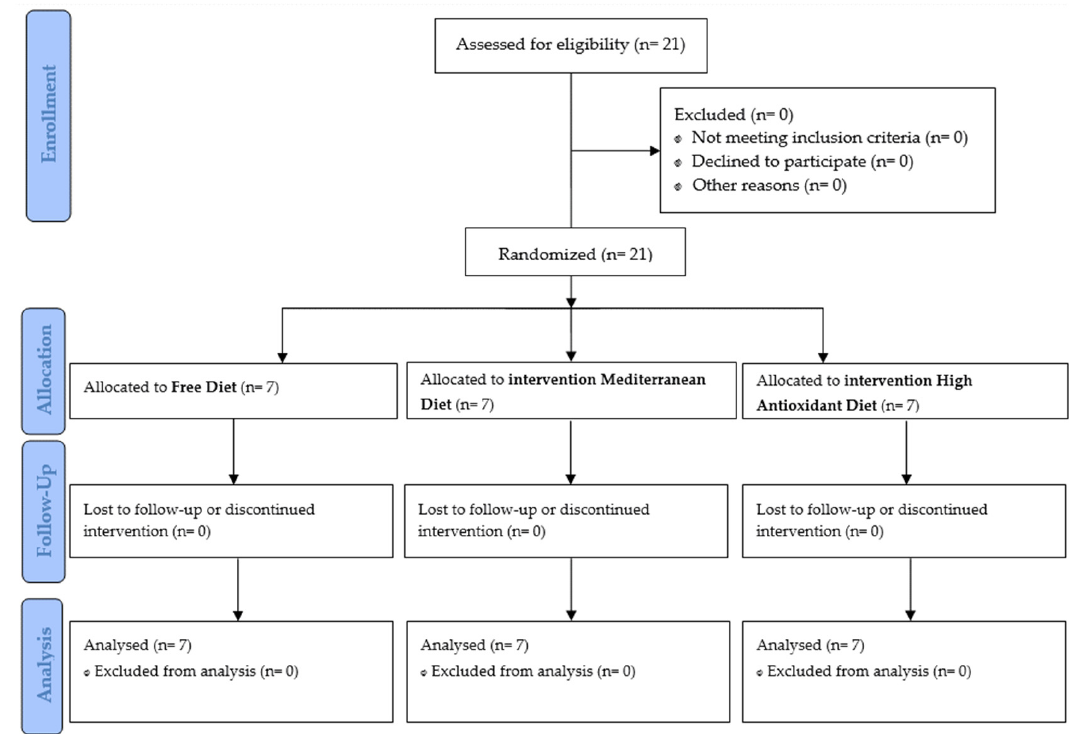
Figure 1. Consort Flow Diagram.